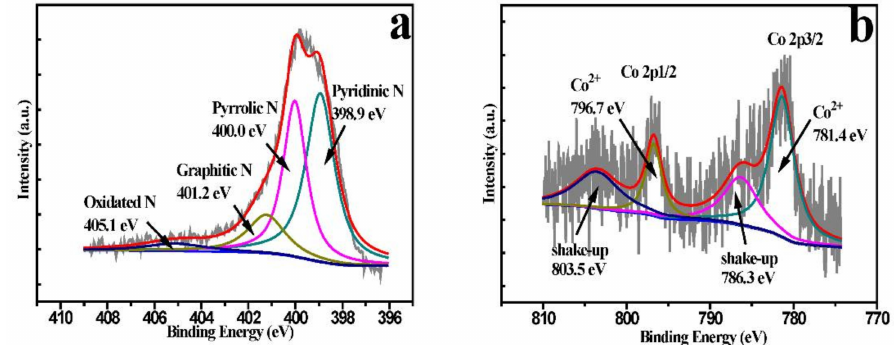
Figure 3. The X-ray photoelectron spectroscopy (XPS) high-resolution N 1s ( a ) and Co 2p ( b ) spectra of Co-N-GCA.